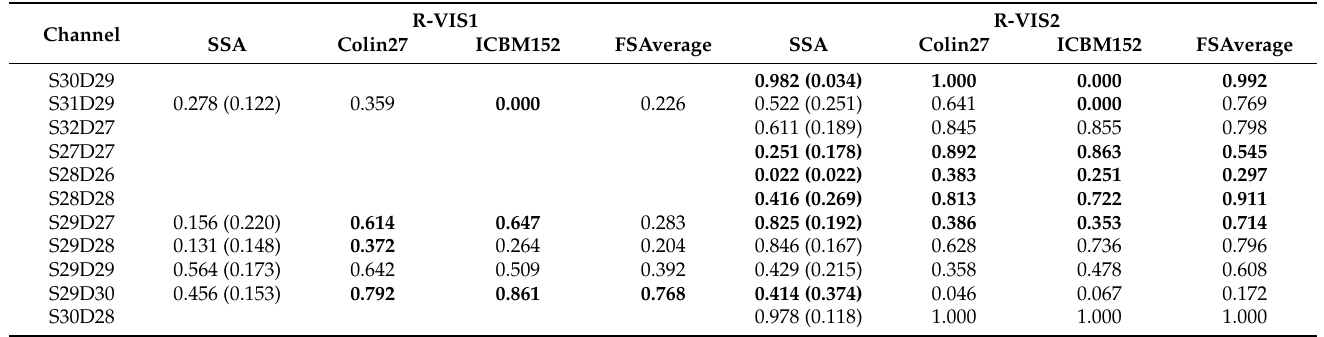
Table 9. Summary of A2Ch coefficients associated to selected right hemisphere functional ROIs: primary (VIS1) and secondary visual network (VIS2). Results are reported for wavelength λ = 760 nm. Bold ABA values indicate channels presenting a 20% difference in A2Ch coefficients from the SSA median.